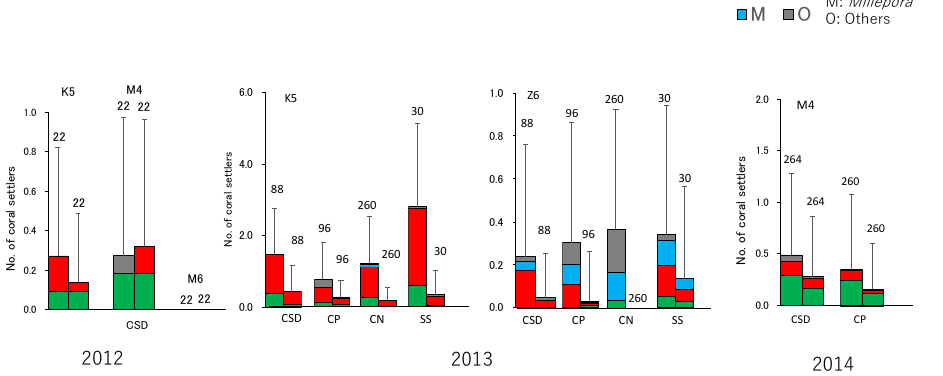
Figure 5. Change in number and standard deviation of coral settlers on the substrata between the